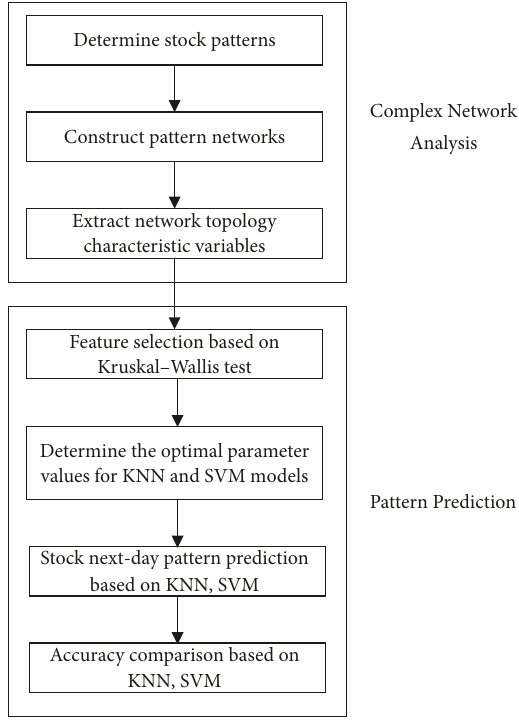
Figure 1: General framework of the stock index pattern prediction.